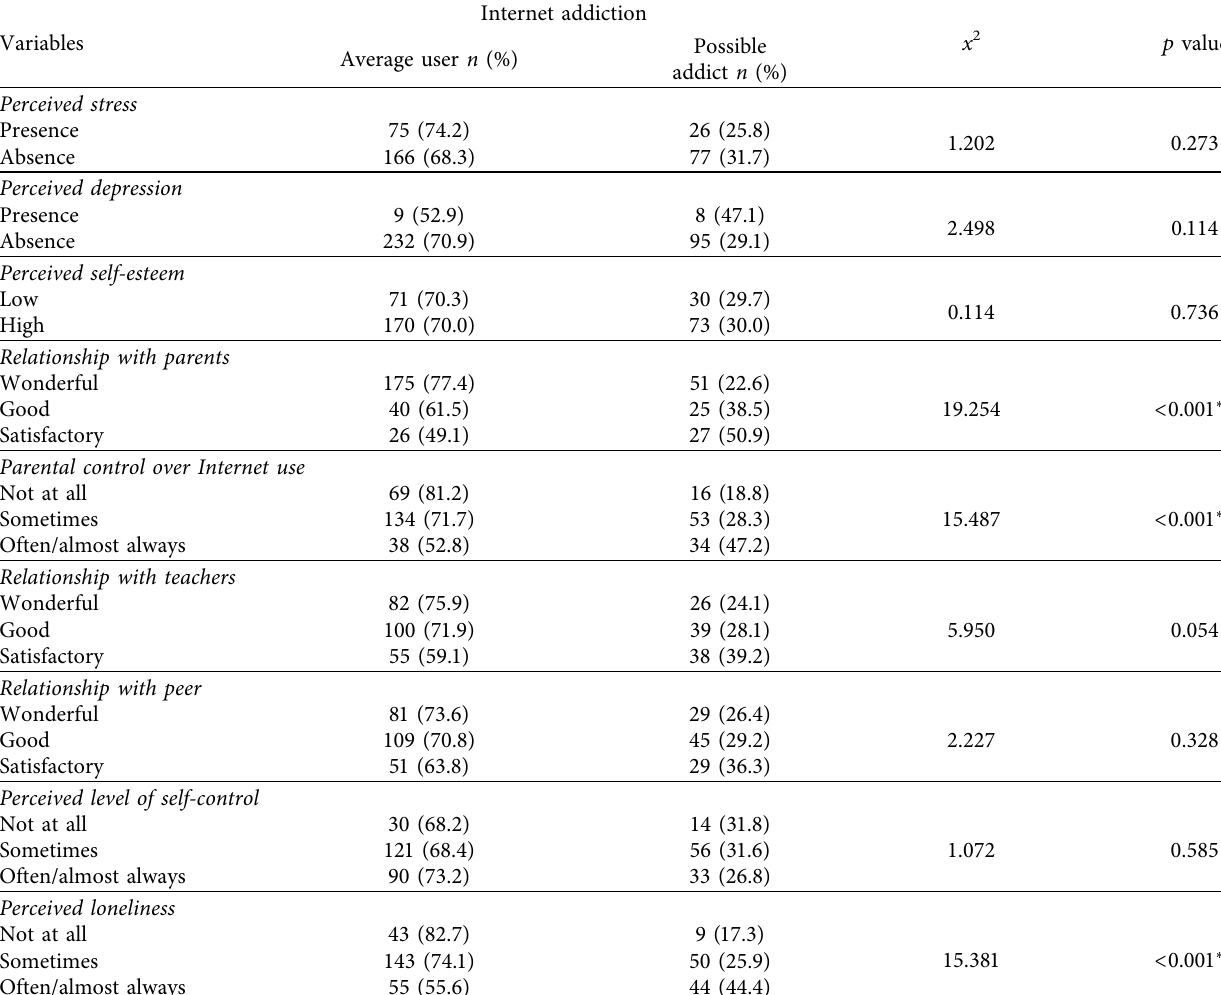
Table 6: Internet addiction and its association with the perceived psychological status and interpersonal relationship. Variables